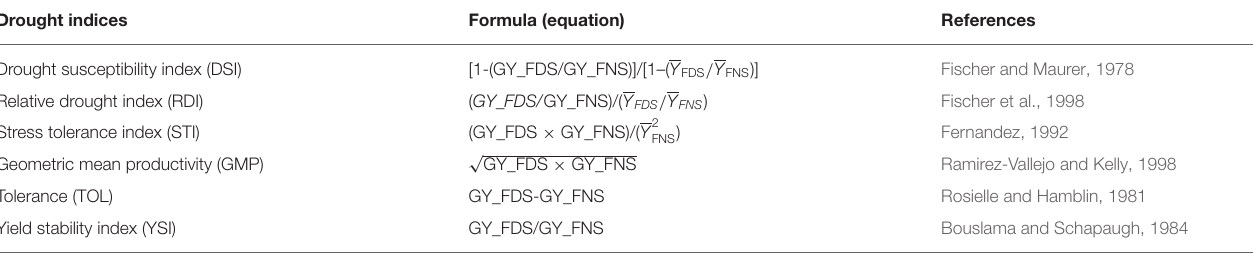
TABLE 1 | Drought indices calculated from grain yield and from traits with a significant positive correlation ( p < 0.001) with grain yield (GY) under FDS and FNS conditions. Drought indices